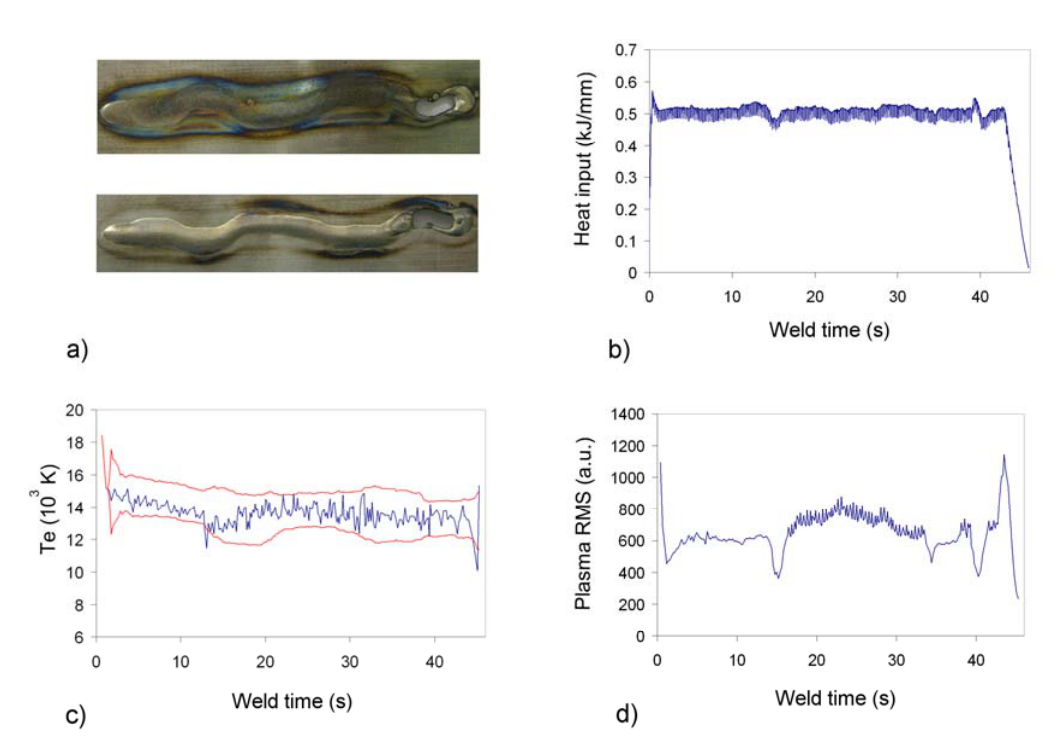
and plasma RMS profiles for defective weld (trajectory deviation) Figure 4. Heat input, T e on Inconel